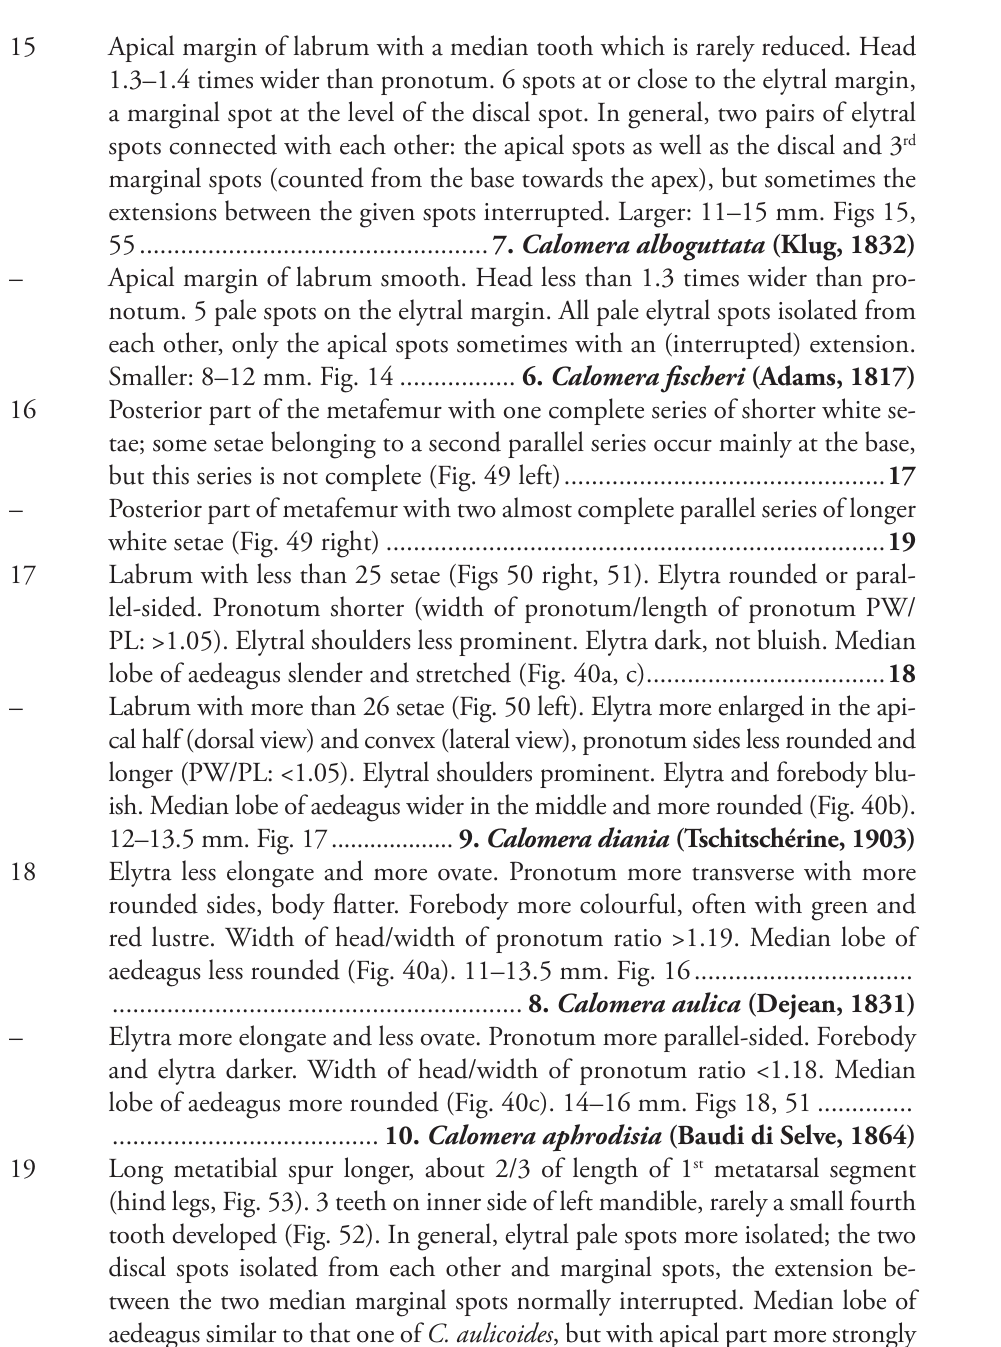
Apical margin of labrum with a median tooth which is rarely reduced. Head 1.3–1.4 times wider than pronotum. 6 spots at or close to the elytral margin, a marginal spot at the level of the discal spot. In general, two pairs of elytral spots connected with each other: the apical spots as well as the discal and 3 rd marginal spots (counted from the base towards the apex), but sometimes the extensions between the given spots interrupted. Larger: 11–15 mm. Figs 15, 55 ................................................... 7. Calomera alboguttata (Klug, 1832) – Apical margin of labrum smooth. Head less than 1.3 times wider than pro- notum. 5 pale spots on the elytral margin. All pale elytral spots isolated from each other, only the apical spots sometimes with an (interrupted) extension. Smaller: 8–12 mm. Fig. 14 ................. 6. Calomera fischeri (Adams, 1817) 16 Posterior part of the metafemur with one complete series of shorter white se- tae; some setae belonging to a second parallel series occur mainly at the base, but this series is not complete (Fig. 49 left) ............................................... 17 – Posterior part of metafemur with two almost complete parallel series of longer white setae (Fig. 49 right) ......................................................................... 19 17 Labrum with less than 25 setae (Figs 50 right, 51). Elytra rounded or paral- lel-sided. Pronotum shorter (width of pronotum/length of pronotum PW/ PL: >1.05). Elytral shoulders less prominent. Elytra dark, not bluish. Median lobe of aedeagus slender and stretched (Fig. 40a, c) ................................... 18 – Labrum with more than 26 setae (Fig. 50 left). Elytra more enlarged in the api- cal half (dorsal view) and convex (lateral view), pronotum sides less rounded and longer (PW/PL: <1.05). Elytral shoulders prominent. Elytra and forebody blu- ish. Median lobe of aedeagus wider in the middle and more rounded (Fig. 40b). 12–13.5 mm. Fig. 17 ................... 9. Calomera diania (Tschitschérine, 1903) 18 Elytra less elongate and more ovate. Pronotum more transverse with more rounded sides, body flatter. Forebody more colourful, often with green and red lustre. Width of head/width of pronotum ratio >1.19. Median lobe of aedeagus less rounded (Fig. 40a). 11–13.5 mm. Fig. 16 ................................ – Elytra more elongate and less ovate. Pronotum more parallel-sided. Forebody and elytra darker. Width of head/width of pronotum ratio <1.18. Median lobe of aedeagus more rounded (Fig. 40c). 14–16 mm. Figs 18, 51 .............. ....................................... 10. Calomera aphrodisia (Baudi di Selve, 1864) 19 Long metatibial spur longer, about 2/3 of length of 1 st metatarsal segment (hind legs, Fig. 53). 3 teeth on inner side of left mandible, rarely a small fourth tooth developed (Fig. 52). In general, elytral pale spots more isolated; the two discal spots isolated from each other and marginal spots, the extension be- tween the two median marginal spots normally interrupted. Median lobe of aedeagus similar to that one of C. aulicoides , but with apical part more strongly bent (Fig. 41). Copulatory piece of median lobe of aedeagus with 2 (or 3) tips which are sideward oriented (Fig. 42 below). 10–13 mm. Fig. 19 ................... ..... 11. Calomera littoralis (Fabricius, 1787), ssp. winkleri (Mandl,